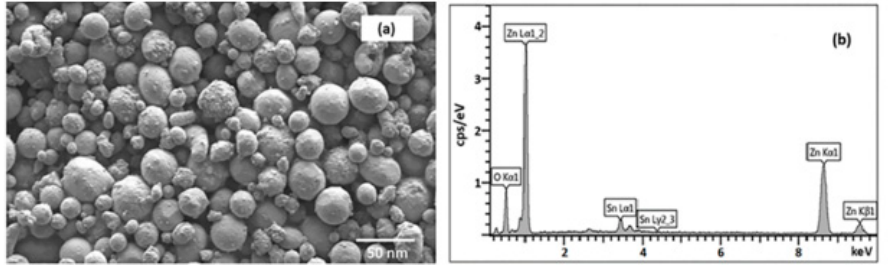
Figure 11. ( a ) SEM micrographs of TZO1 particles synthesized at 10 kW. ( b ) EDS spectrum for TZO1 sample synthesized at 10 kW. Reproduced with permission from Ref. [32]; published by Springer Nature, 2018.